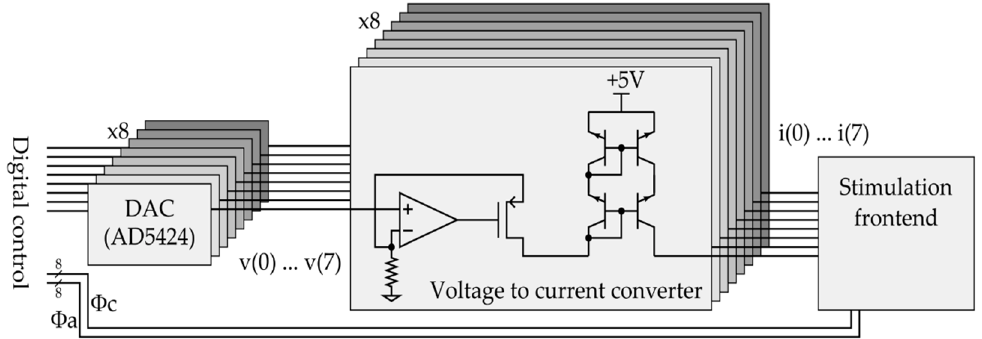
Figure 6. D/A stage (DAC followed by Voltage to Current Converter) implemented on TWIST with off-the shelf